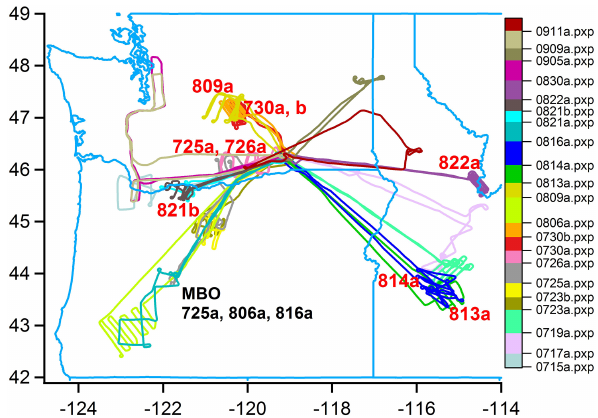
Figure 1. Ground track of G-1 aircraft for 21 BBOP flights in the Pacific Northwest. Nine flights that were used in time evolution analysis are identified on the map with red